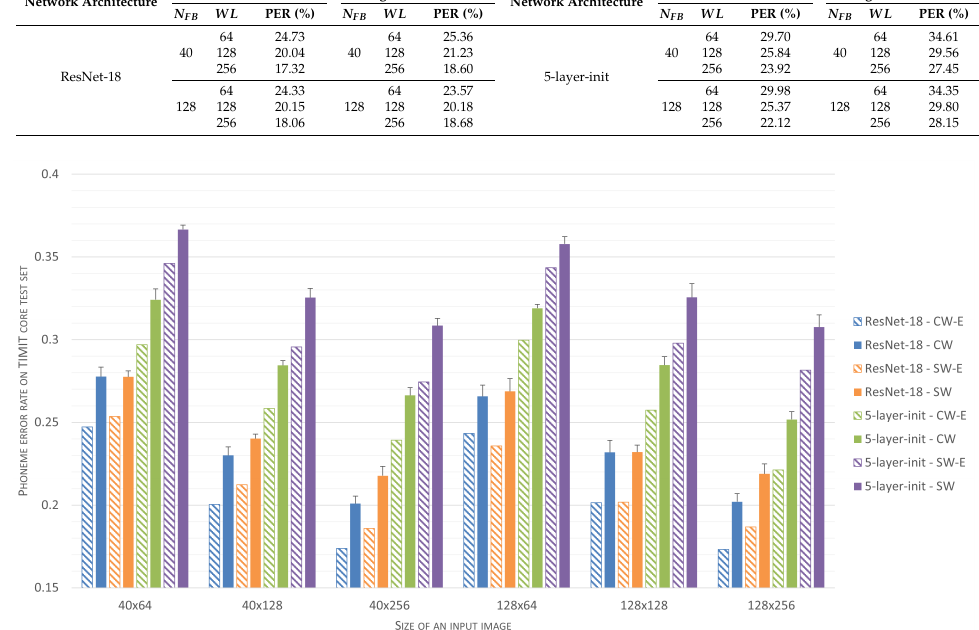
Figure 10. Phoneme error rates calculated for individual classifiers and their ensembles, determined for six groups of experiments, involving different shapes of input Mel-Spectrogram windows (either 40 or 128 rows and 64, 128, and 256 columns). Performance of Res-Net-18 and the derived CNNs, trained either with the proposed central-window scheme (suffix CW) or sliding window (suffix SW), is shown. For each experiment, three different frame-lengths (128, 256 and 512) were used to preprocess input speech. Mean performance for three individual classifiers is shown using solid bars with whiskers denoting 99% confidence intervals, whereas performance for three-element classifier ensembles is presented using dashed bars.